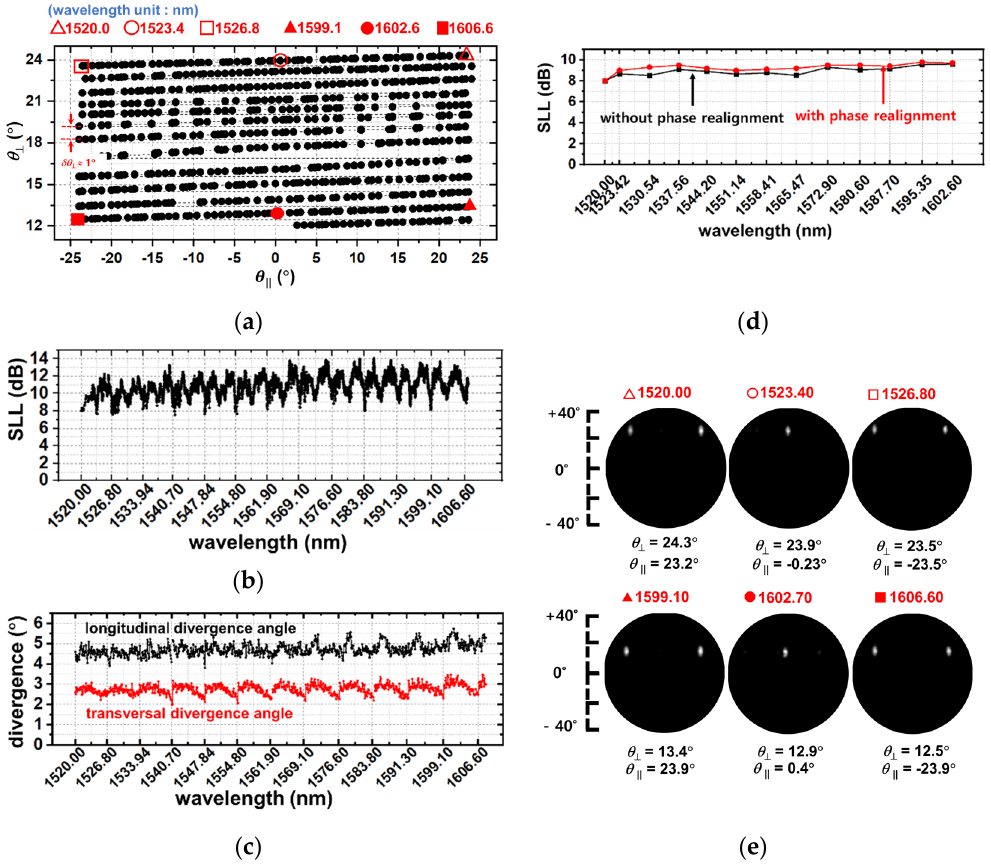
Figure 5. Measured results of beam positions and qualities during 2-D beam steering by an increasing wavelength after one-time phase initialization: ( a ) Traces of the beam center, ( b ) variation of the SLL, ( c ) variation of divergence angles, ( d ) difference in the SLL with, and without, the phase realignment process and ( e ) measured far-field patterns corresponding to each of the three points on the first and last full trace in ( a ).